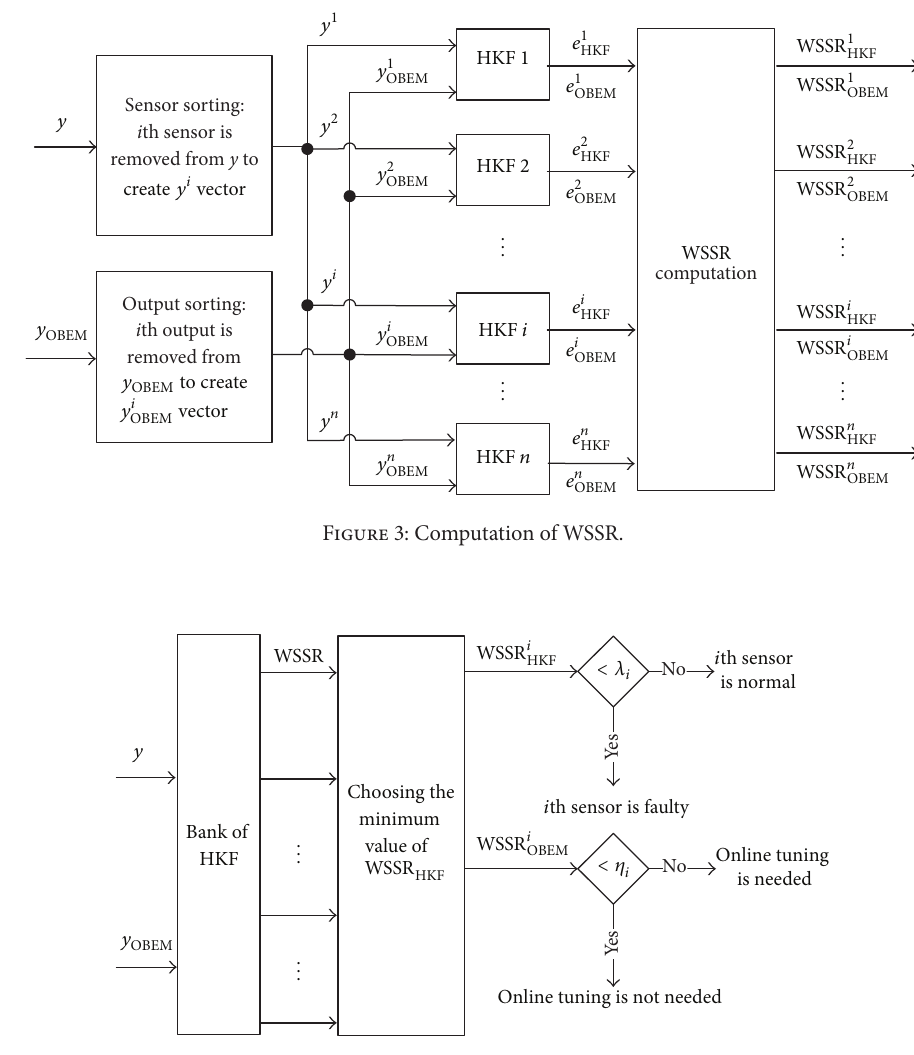
Figure 4: Sensor fault detection and online tuning decision